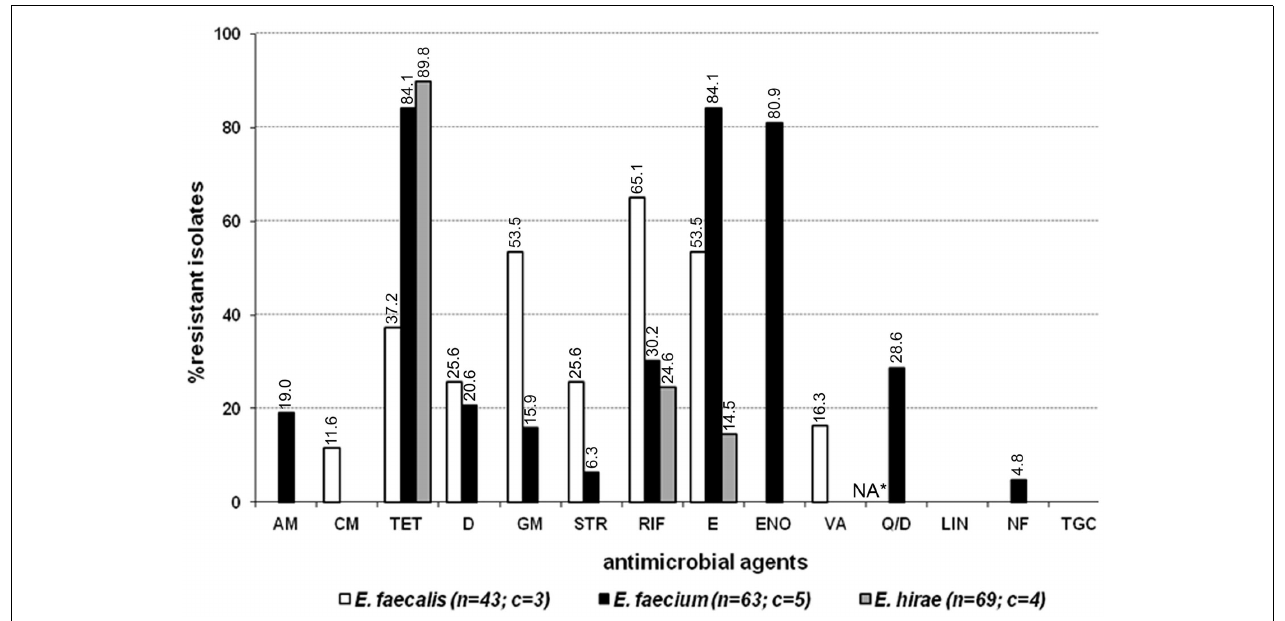
vancomycin; Q/D, quinupristin/dalfopristin; LIN, linezolid; NF, nitrofurantoin; TGC, tigecycline; c , number of cats that contributed for the total number ( n ) of isolates. *Not applicable for E. faecalis isolates due to their intrinsic resistance.